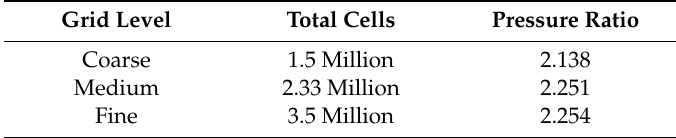
Table 2. E ff ects of the compressor grid on the calculation